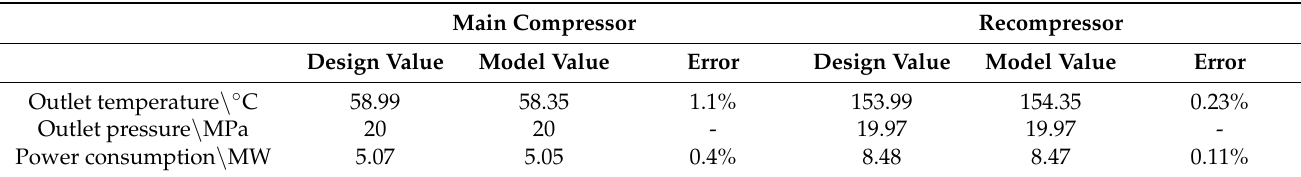
Table 3. Comparison of the compressor.